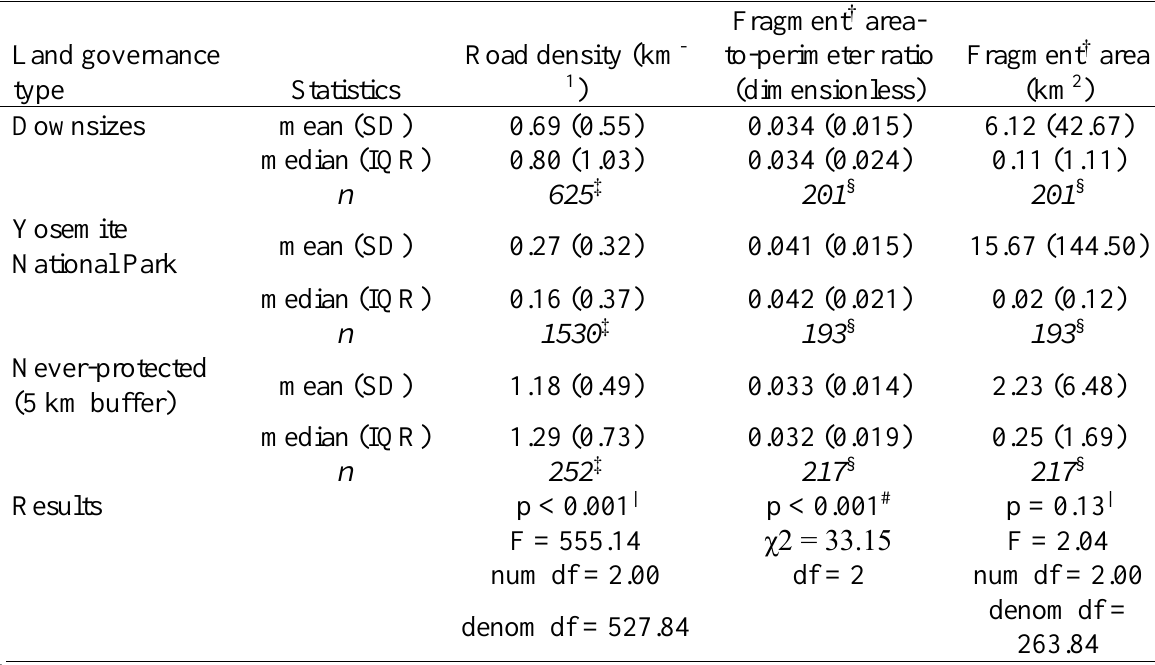
Table A1.12: Habitat fragmentation indicators at the Park scale for all land cover types – sensitivity test using a 5 km never-protected lands buffer demonstrate the same results as with a 1 km buffer. See Table A1.13 for results of post-hoc